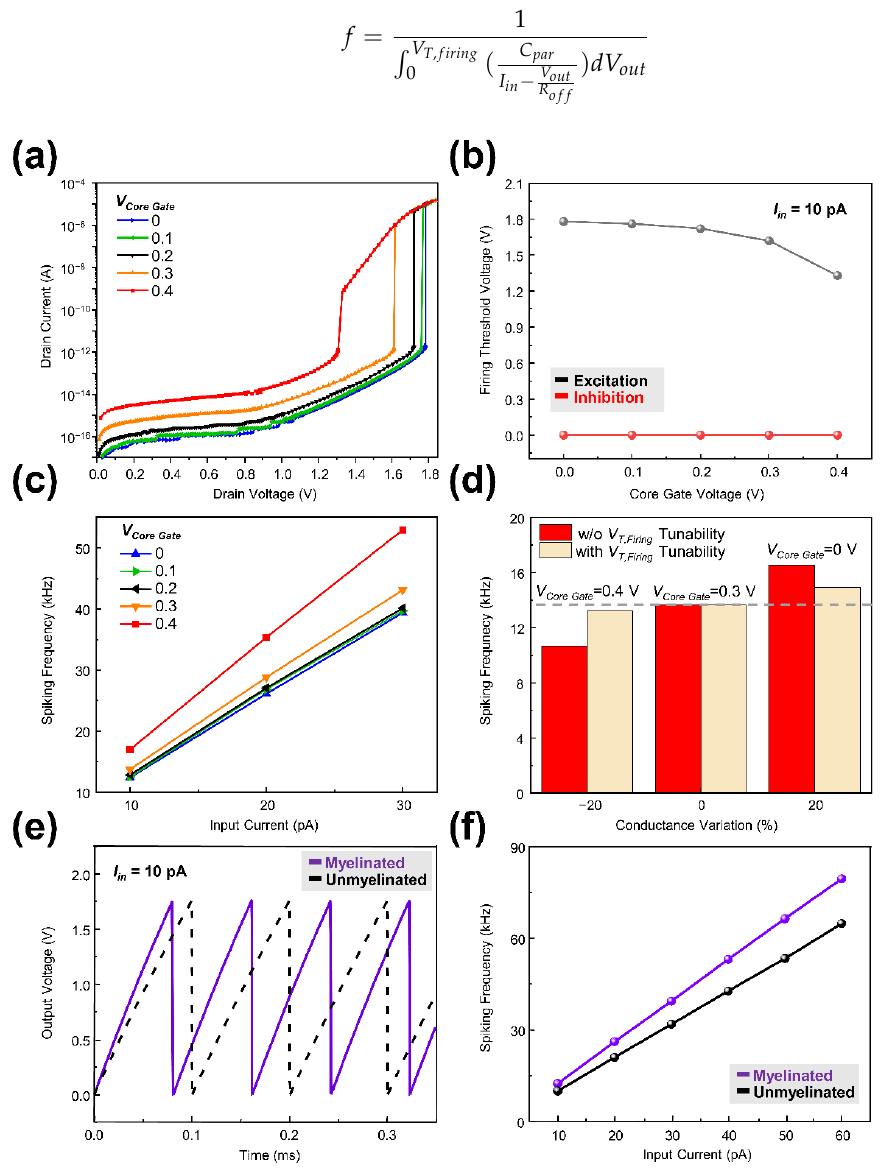
Figure 4. ( a ) I D -V D curves of the CSDG NW neuron device under different core gate bias; ( b ) firing threshold voltage of the CSDG NW neuron device under different core gate bias; ( c ) Spiking frequency of the CSDG NW neuron device depending on the core gate bias and the input current; ( d ) Spiking frequency with and without tunable firing threshold voltage under conductance variations of −20%, 0%, and 20%; ( e ) Comparison of the output voltage between myelinated neuron and unmyelinated neuron; ( f ) Spiking frequency of the myelinated and unmyelinated neuron depending on the input current. Note that the spiking frequency is the function of the firing threshold voltage and the input current. Under the same constant input current of 10 pA, the spiking frequency of neuron was increased from 12.372 kHz to 16.955 kHz as core gate bias increased from 0